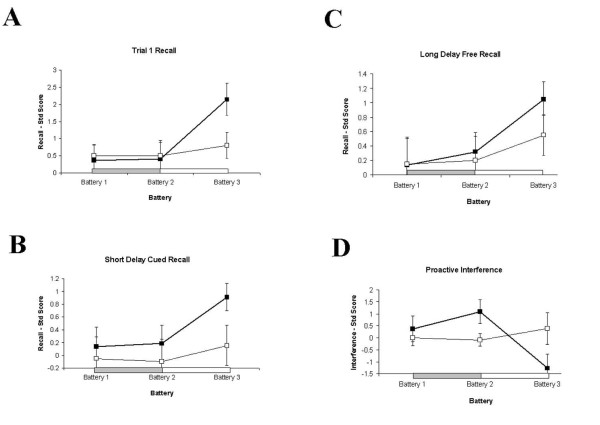
Behavioural data showing recall on four CVLT subscales across batteries and groups. Four selected subscales of the CVLT demonstrating delayed six-week memory facilitation for Group A (heavy line, filled squares). Horizontal bars represent 6-week learning blocks for Group A (grey bar) and Group B (white bar). A) Word recall on Trial 1, showing significant increase in recall for ote A relative to Group B (thin line, empty squares) at Battery 3. B) Short Delay Cued Recall for Group A and Group B, also exhibiting significant improvement at Battery 3. C) Long Delay Free Recall for Group A and Group B, showing the same pattern of delayed facilitation at Battery 3. D) Proactive Interference for the two groups, showing a significant decrease in interference for Group A at Battery 3. This pattern of delayed enhancement of memory was also found for Trial 5, Total Trials 1-5, Semantic Clustering and Subjective Clustering (not shown).